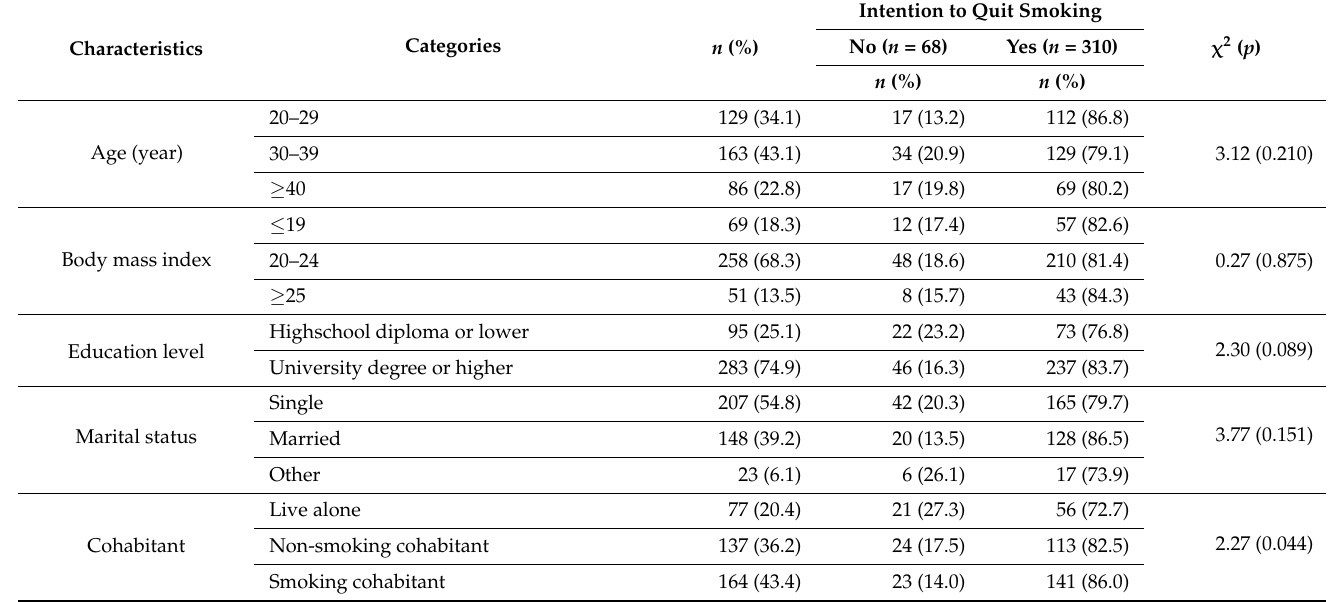
Table 1. Differences in the Intention to Quit Smoking according to the General and Workplace Characteristics of Participants ( n =